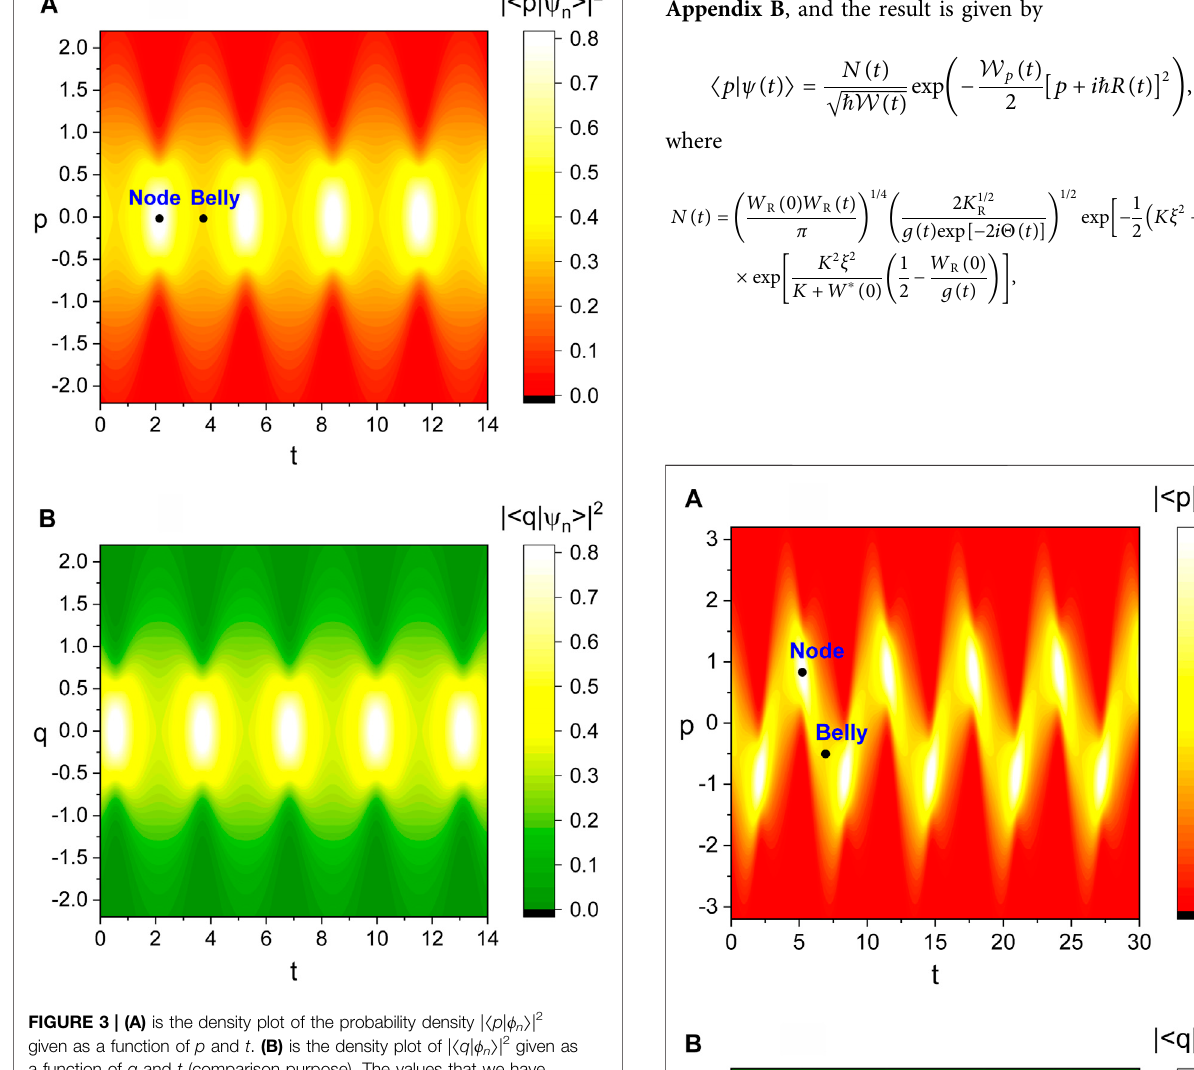
Frontiers in Physics |